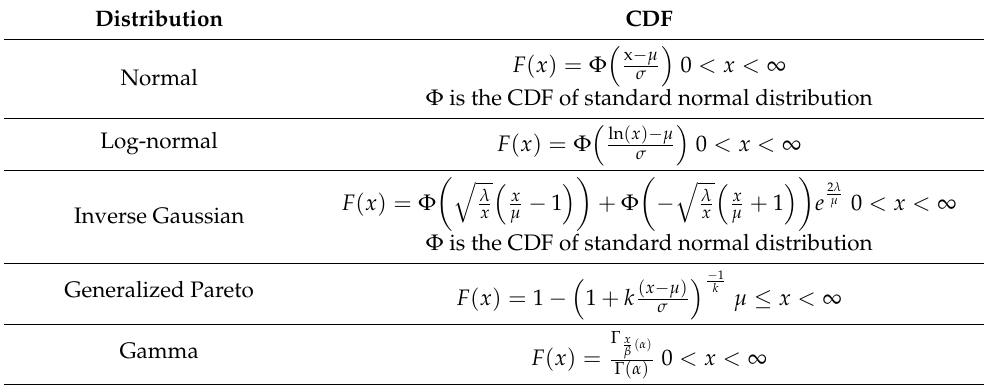
Table 2. The distribution functions used in this